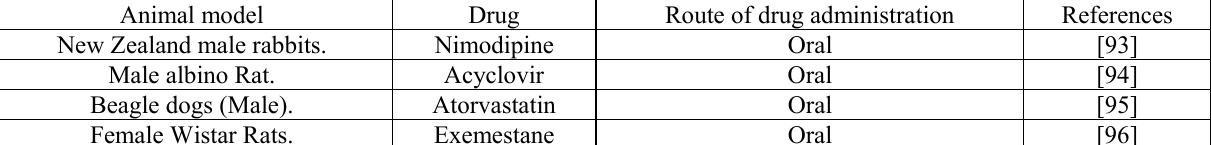
Different animal models utilized for in-vivo absorption studies in SMEDDS Animal model Drug Route of drug